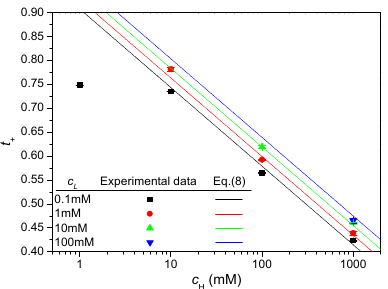
Figure 7. Transference number for various concentrations of both NaCl solutions.